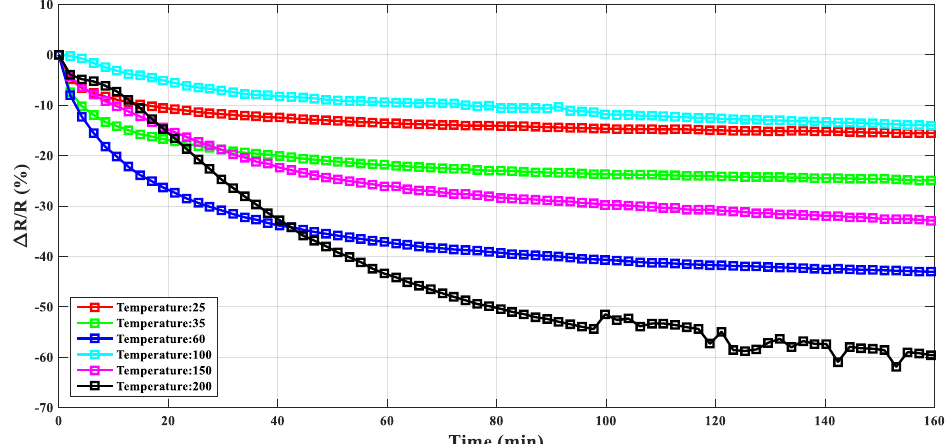
Figure 3. Comparison of the ratio of the electrical resistance variation for the composite gasket under the creep process (with constant holding force: 1000 N) at different temperatures (from 25 °C to 200 °C).